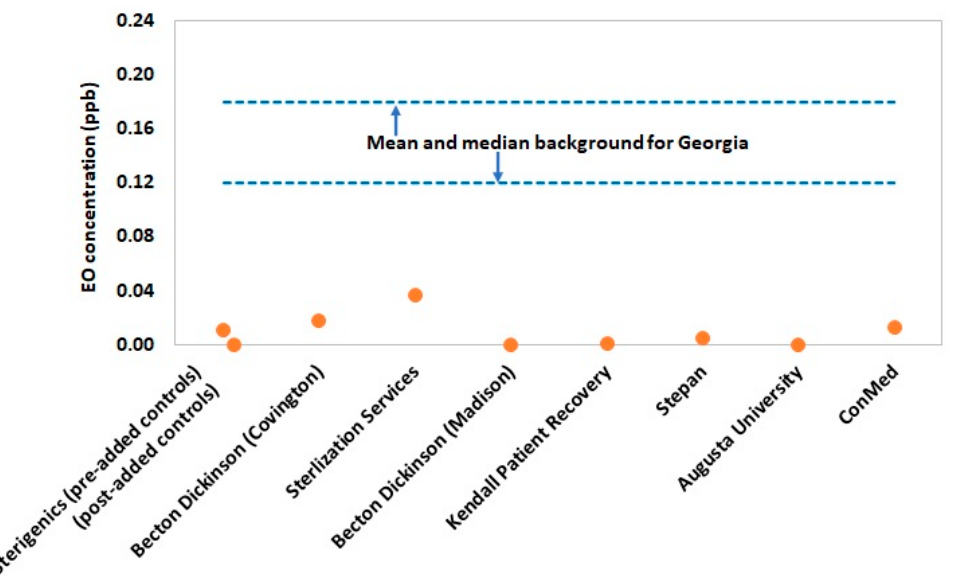
Figure 3. Highest modeled 5-year average EO concentration for all residential receptors by facility (in absence of background contribution) relative to the mean background EO concentration for Georgia (0.18 ppb). One facility (Sterigenics) had modeling data corresponding to two different time periods, which were delineated by the addition of supplemental EO emission controls.